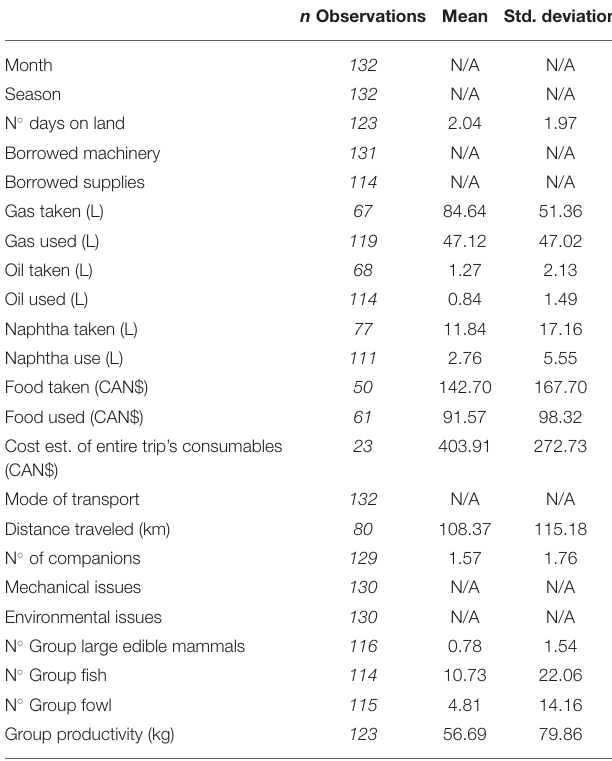
TABLE 1 | Summary of variables explored in statistical analysis. n Observations Mean Std.